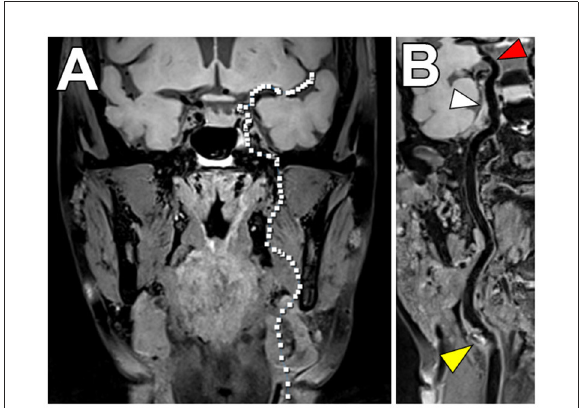
FIGURE8 Joint VW-MRI of the extracranial and intracranial arteries. (A) Coronal precontrast VW-MRI image shows the coverage of the joint intracranial and extracranial VW-MR image. (B) A curved reformatted image of the left cervico-cranial carotid artery shows intrinsic T1 hyperintense signal at the carotid bulb (yellow arrowhead), which was favored to be the culprit source of plaque in this patient with ischemic strokes. The intracranial internal carotid artery at the siphon (white arrowhead) and M1 middle cerebral artery segment (red arrowhead) showed no significant wall thickening to suggest intracranial atherosclerosis.